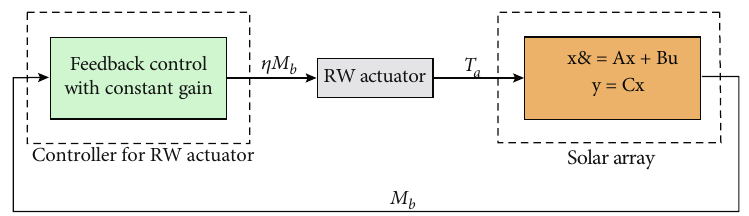
Figure 3: Diagram of the feedback control with constant gain.